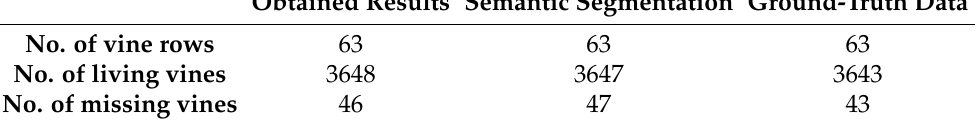
Table 5. Vine identification (Parcel 59B). Results from proposed method, semantic segmentation, and ground-truth